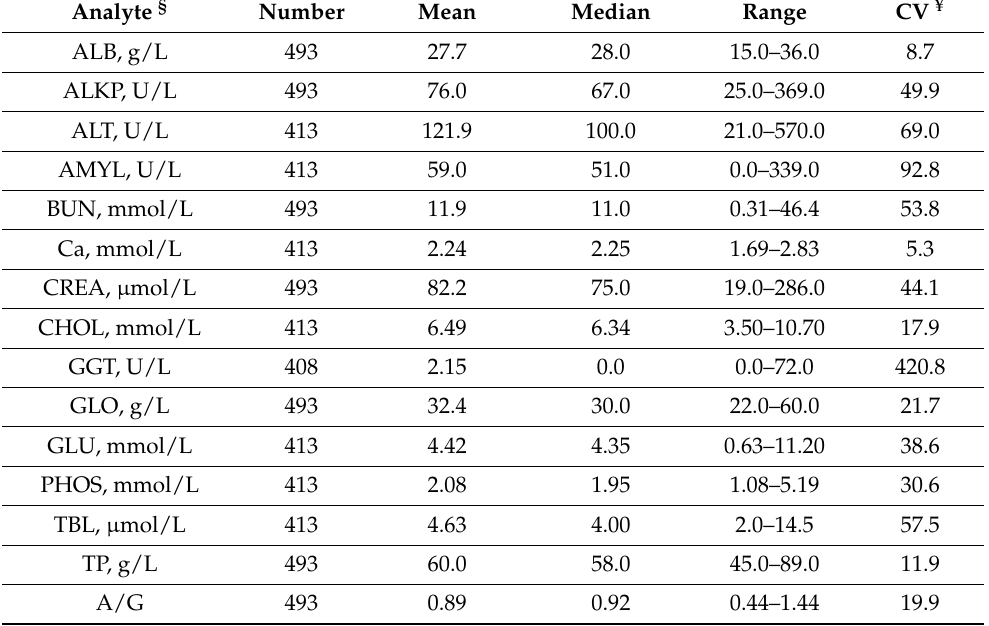
Table 1. Descriptive statistics of serum analytes at